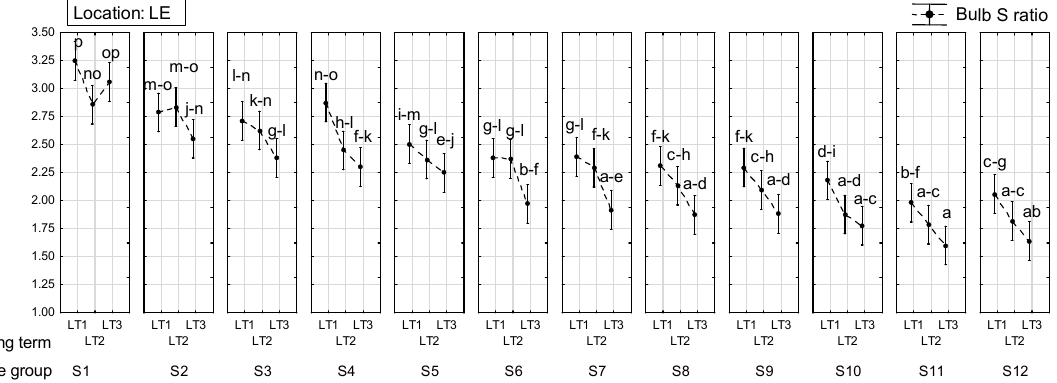
Figure 9. Effect of size group and lifting term on bulb S ratios for Lednice (LE) location. Mean values with different letter are significantly different according to Duncan’s multiple range test at p ≤ 0.05. For treatments description, see Sections 2.1–2.4, Materials and Methods sections.